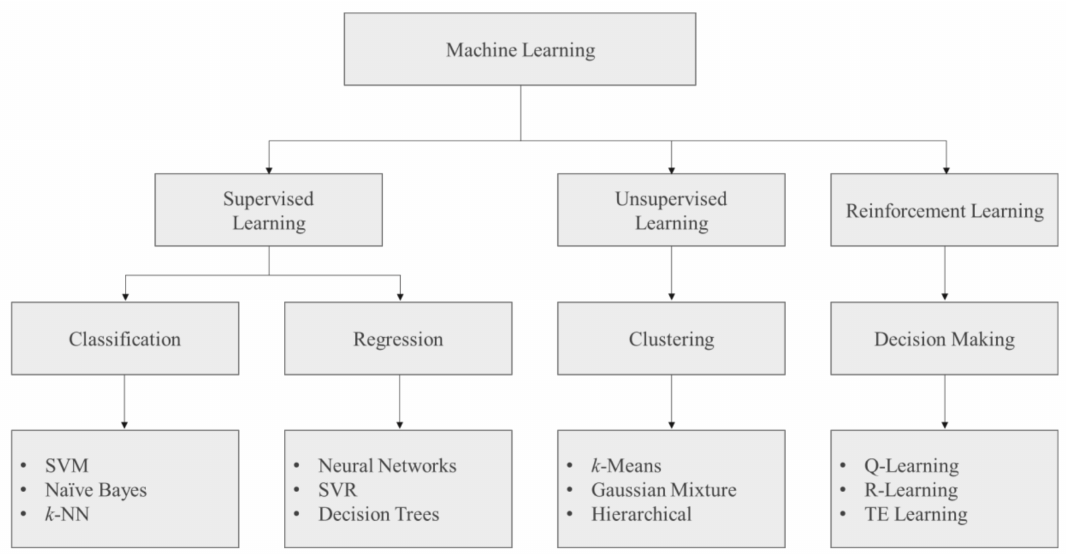
Figure 2. Types of machine learning.